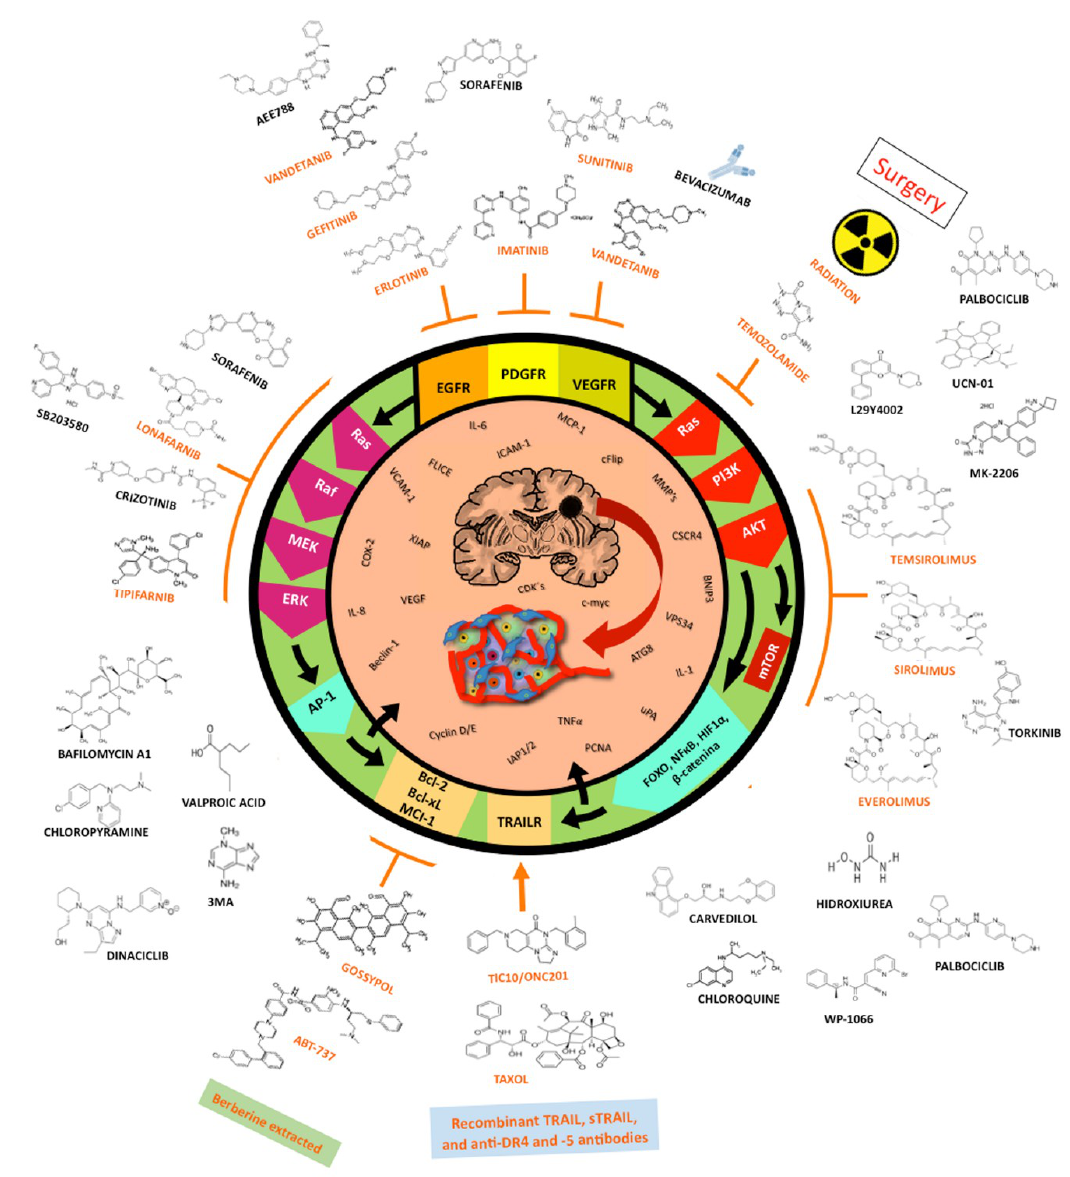
Figure 8. Several therapeutic modalities have been assayed to potentiate cell death in glioblastoma, including activators of apoptotic autophagy cell death as well as inhibitors of the autophagy process. The drugs most widely used in the clinic to treat GBM are temozolamide with radiation and surgery; tyrosine-kinase inhibitors (TKIs) (gefitinib and erlotinib); imatinib mesylate (an inhibitor of PDGFR), sunitinib, vandetanib, and vatalanib (VEGF inhibitors); tipifarnib and lonafarnib (RAS/RAF/MAPK pathway inhibitors); temsirolimus, everolimus, and sirolimus (PI3K/AKT/mTOR pathways inhibitors); Bcl-2 inhibitors (ABT-737, gossypol, and berberine); and TRAIL/TRAILR pathway activators (recombinant TRAIL, sTRAIL, and anti-DR4 and -5 antibodies, taxol, and TIC10/ONC201). All these compounds increase their antineoplastic activity when more than one are administered or when they are combined with other antineoplastic compounds like crizotinib (a c-Met pathway inhibitor), sorafenib (an inhibitor of VEGFR2, PDGF, and RAF), bafilomycin A1, chloroquine and 3MA (autophagy inhibitors), MK-2206 (an AKT inhibitor), valproic acid (an activator of the LKB1/AMPK pathway), SB203580 (an inhibitor of p38 MAPK), palbociclib (an inhibitor of CDK4/6), AEE788 (which inhibits EGFR and VEGRF), bevacizumab (antibody against VEGF), LY294002 (an inhibitor of PI3K), UCN-01 (an inhibitor of AKT), torkinib (an mTOR inhibitor), and dinaciclib (a CDK inhibitor). Continue arrows ( ↓ ) mean activation, and truncated arrows ( ⊥ ) mean